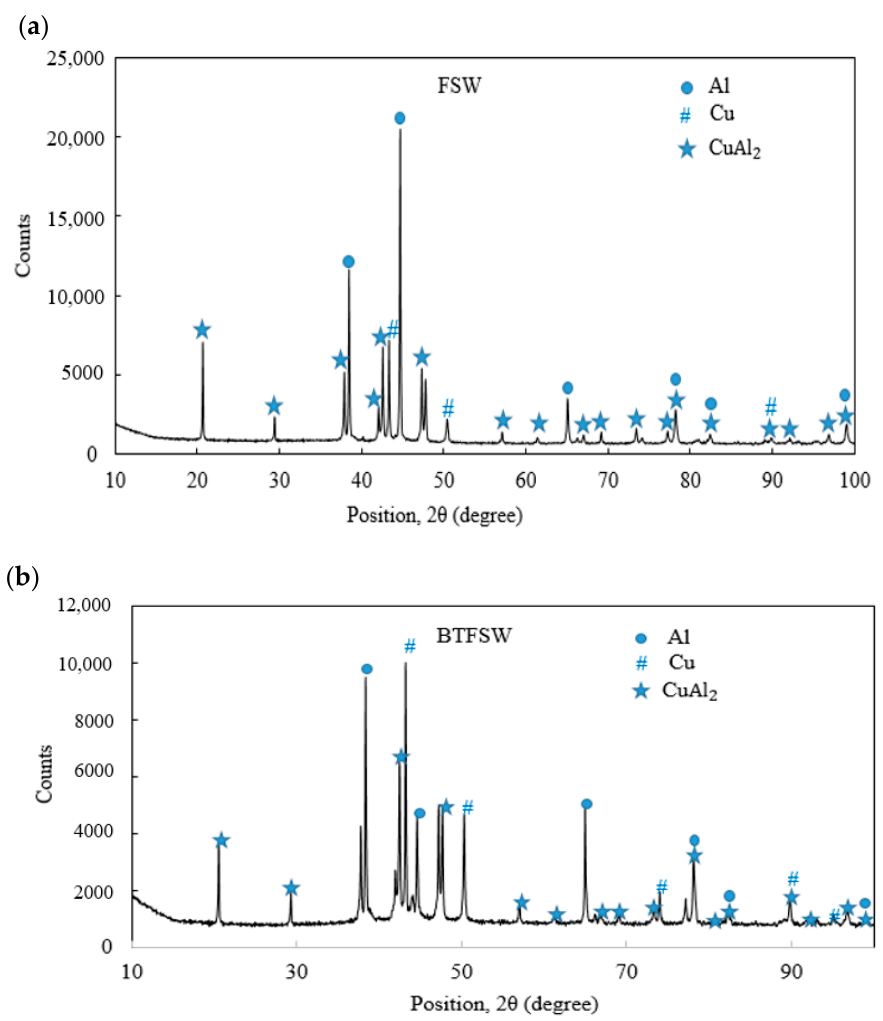
Figure 9. XRD results ( a ) CFSW ( b ) BTFSW.